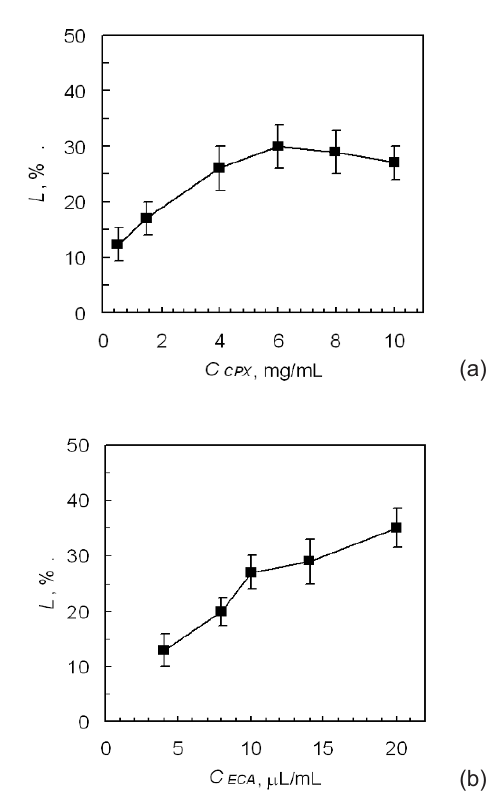
Figure 5. Dependence of the drug loading efficiency (L) on the: (a) concentration of ECA (at constant CPX concentration of 2 mg mL -1 ); (b) concentration of CPX (at constant ECA concentration of 10 μL mL -1